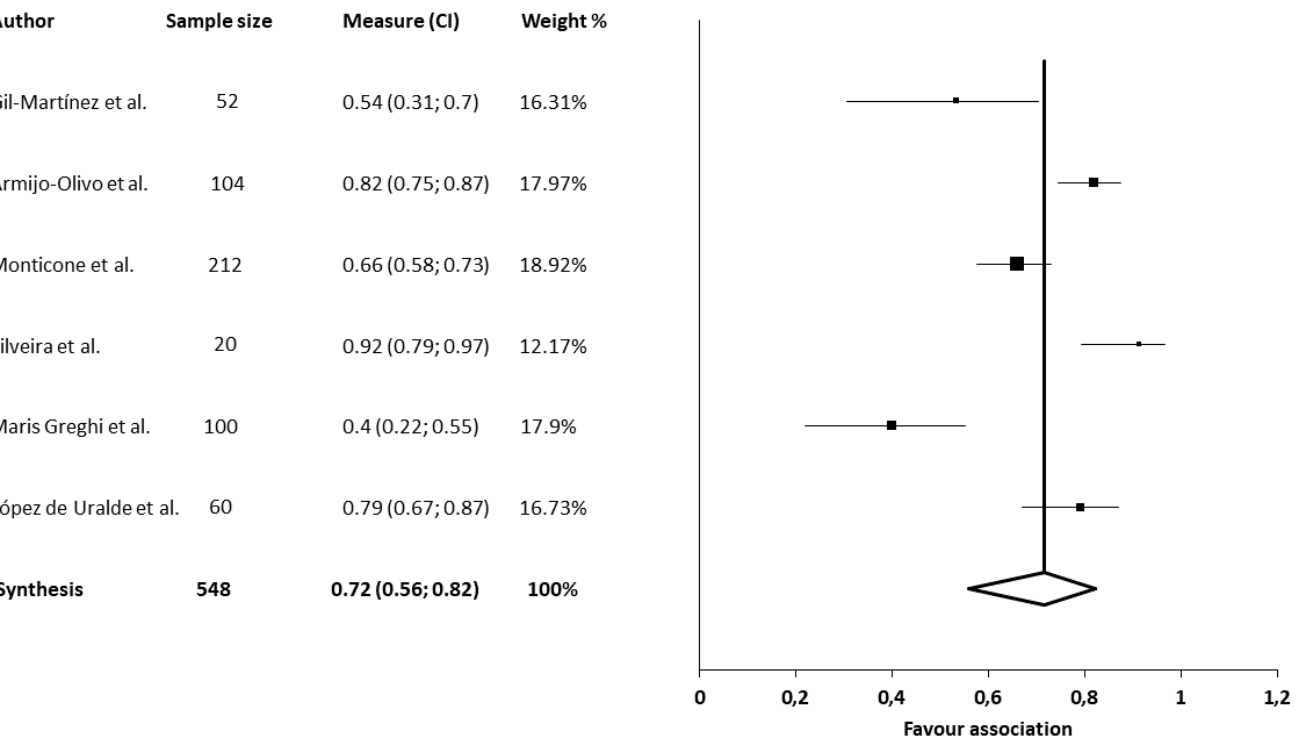
Figure 2. Synthesis forest plot for the association between cervical and mandibular disability. SMD, standardized mean di ff erence. This forest plot summarizes the results of six included studies (sample size, standardized mean di ff erences (SMDs), and weight). The small boxes with the squares represent the point estimate of the e ff ect size and sample size. The lines on either side of the box represent a 95% confidence interval (CI). The horizontal axis represents whether the quantitative analysis is for or against the association.